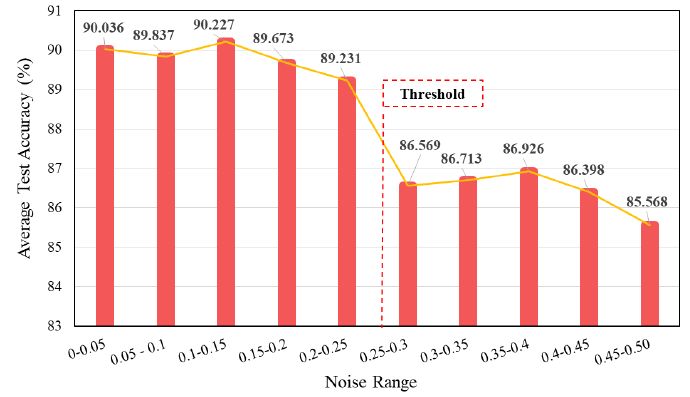
Figure 6. Evaluating results for selecting the optimal noise